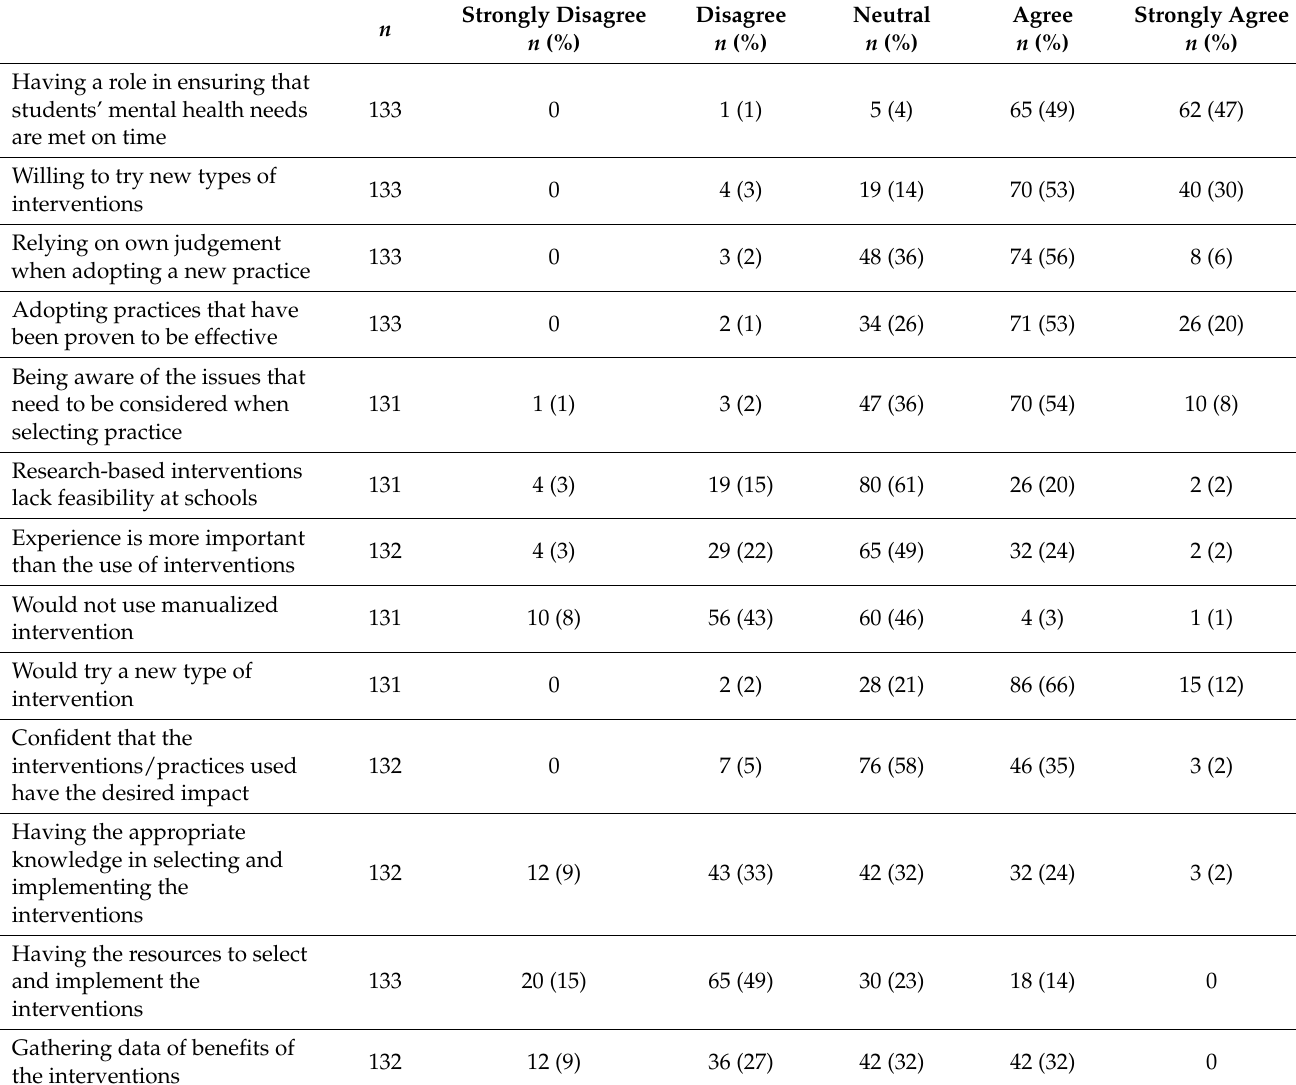
Table 1. School nurses’ attitudes and role regarding mental health interventions and practices.